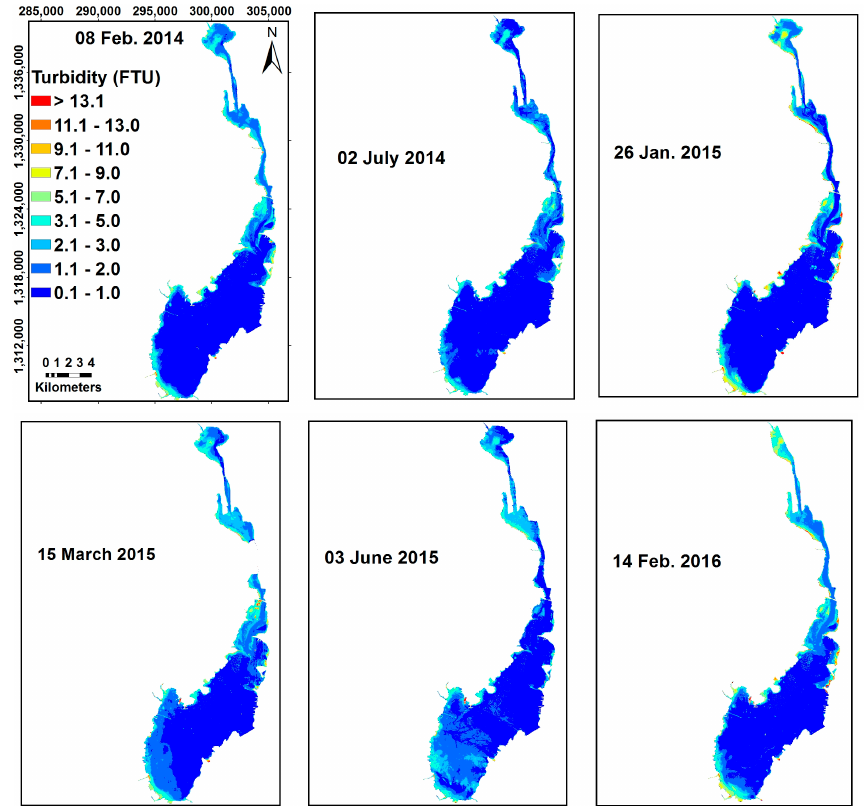
Figure 6. Turbidity distributions in dry season (cloud cover areas masked).